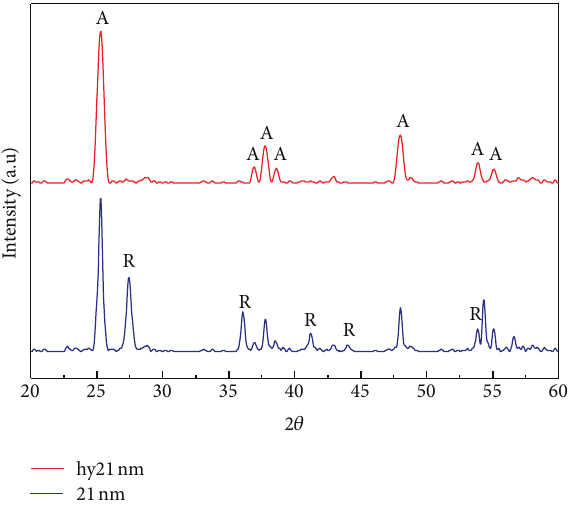
Figure 3: XRD spectra of TiO 2 thin films prepared by hydrothermal method (red color) and commercial particle (blue color).